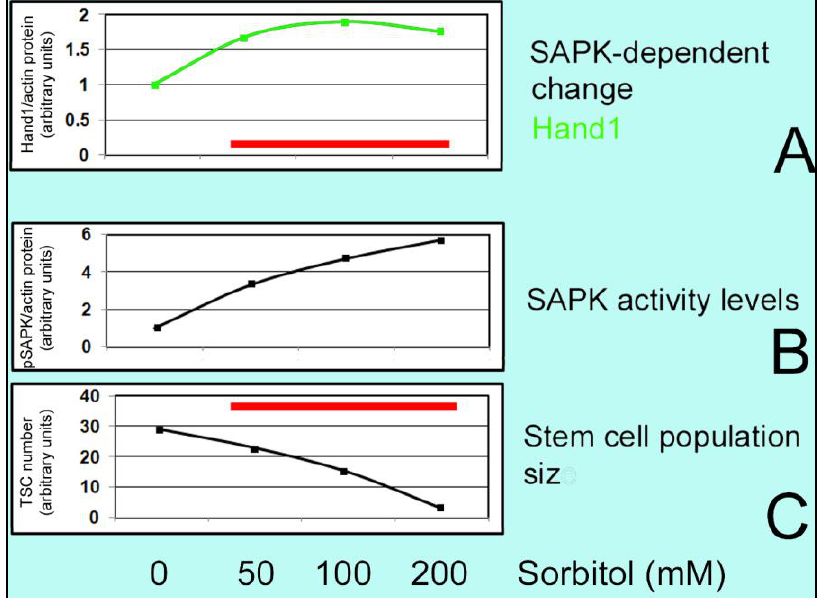
Figure 2. S-shaped curve for compensatory and prioritized differentiation with a reverse S-shaped curve for stem cell accumulation. As the dose of hyperosmolar stress (sorbitol) increases, the stem cell accumulation rate decreases (C.) but the stress enzyme (SAPK) activity level (B) and differentiation marker (Hand 1) (A) level rise. Standard error of the mean was between 1% (cid:177) 8% of the mean. Red bars in (A) and (C) show range of stress-induced